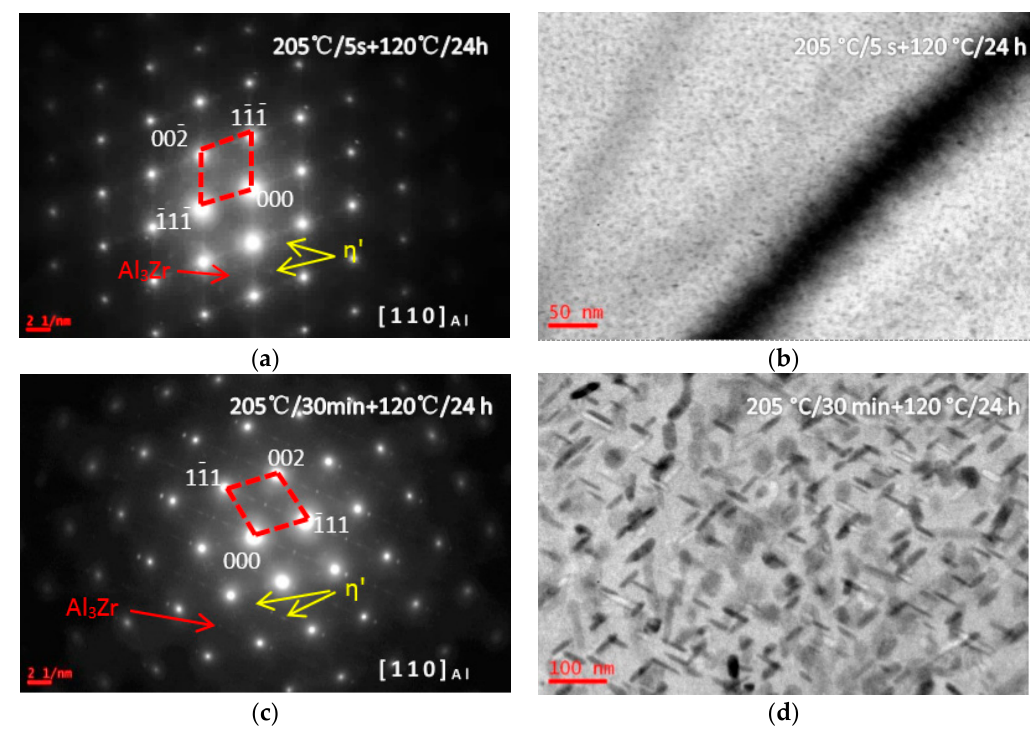
Figure 6. SADPs and BF images of the studied alloy having been isothermal heat treated at 205 °C for different durations (5 s and 30 min), and then aged at 120 °C for 24 h. ( a ) SADP from the area in ( b ); ( b ) the isothermal heat treatment is 5 s; ( c ) SADP from the area in (d); and ( d ) isothermal heat treatment is 30 min.